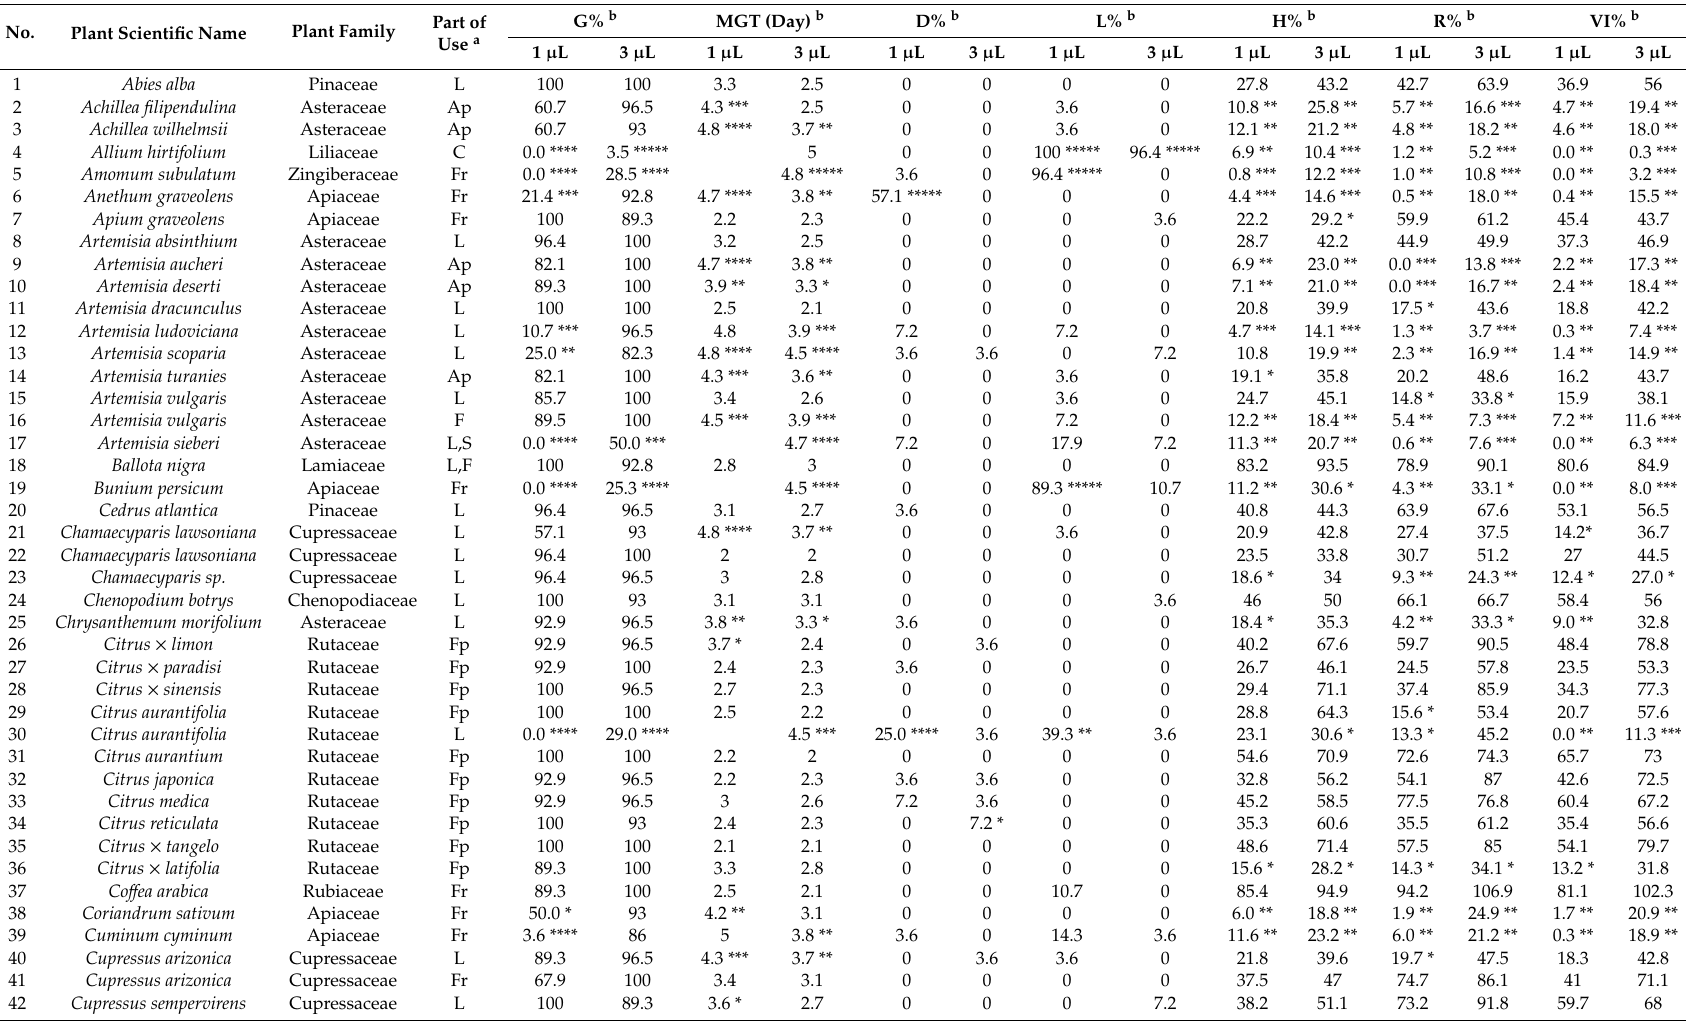
Table 1. The results of evaluation of inhibitory potential of medicinal plants EO on traits related to seed germination and seedling growth of lettuce.